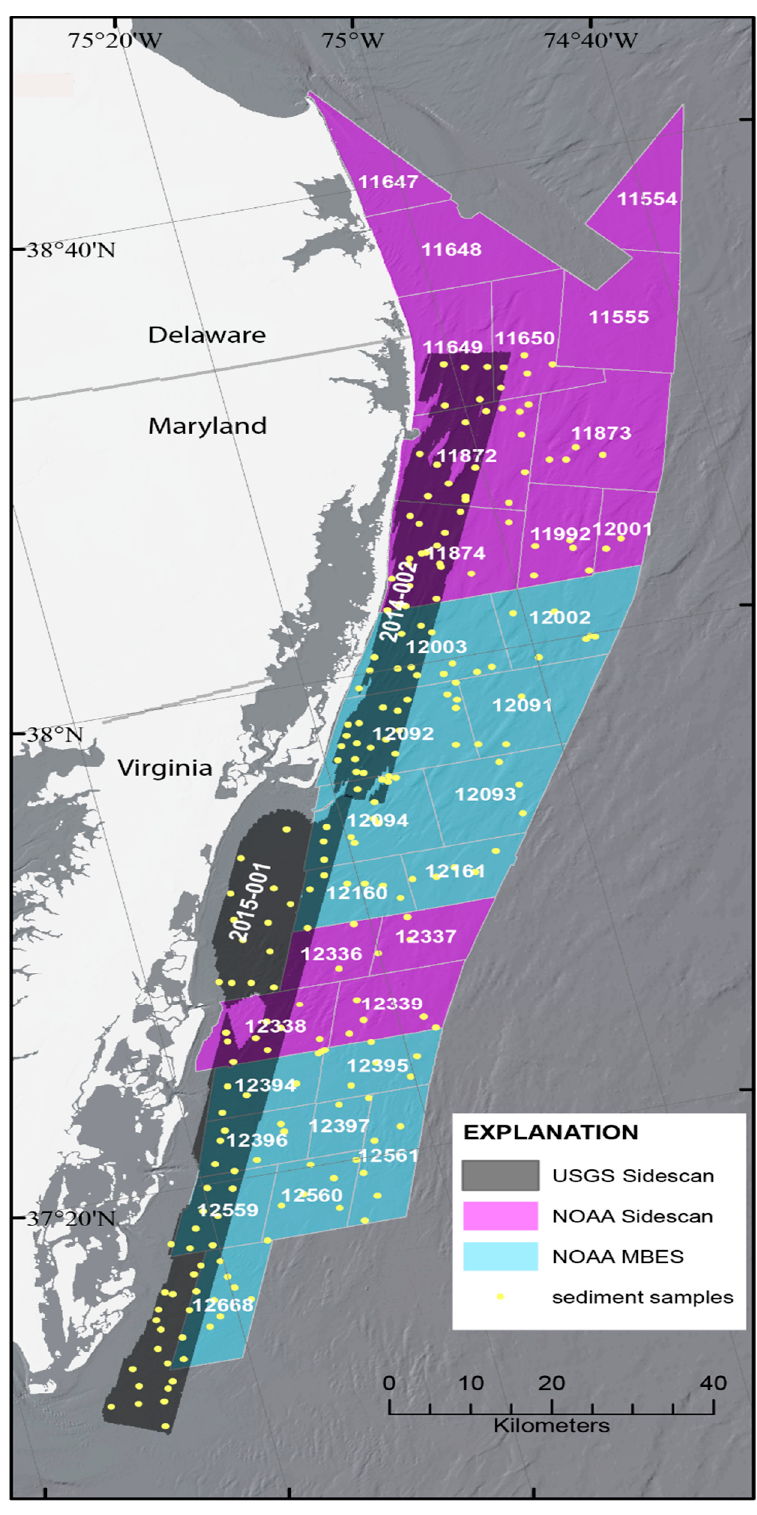
Figure 2. Map showing the location of NOAA surveys collected in 2006–2013 and U.S. Geological Survey (USGS) surveys collected in 2014–2015 along with sample and bottom photo locations.